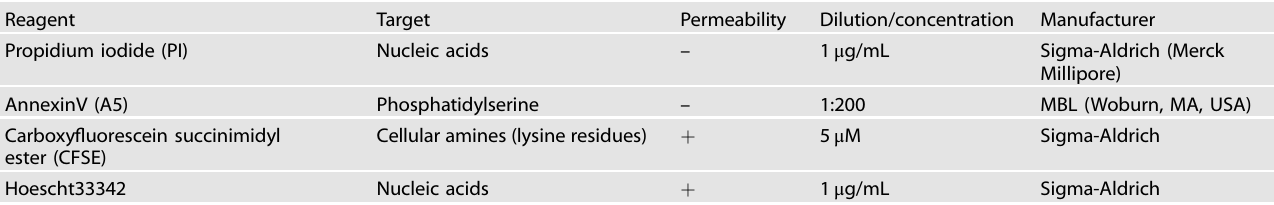
Table 2. Target, dilutions, and concentrations of reagents used for